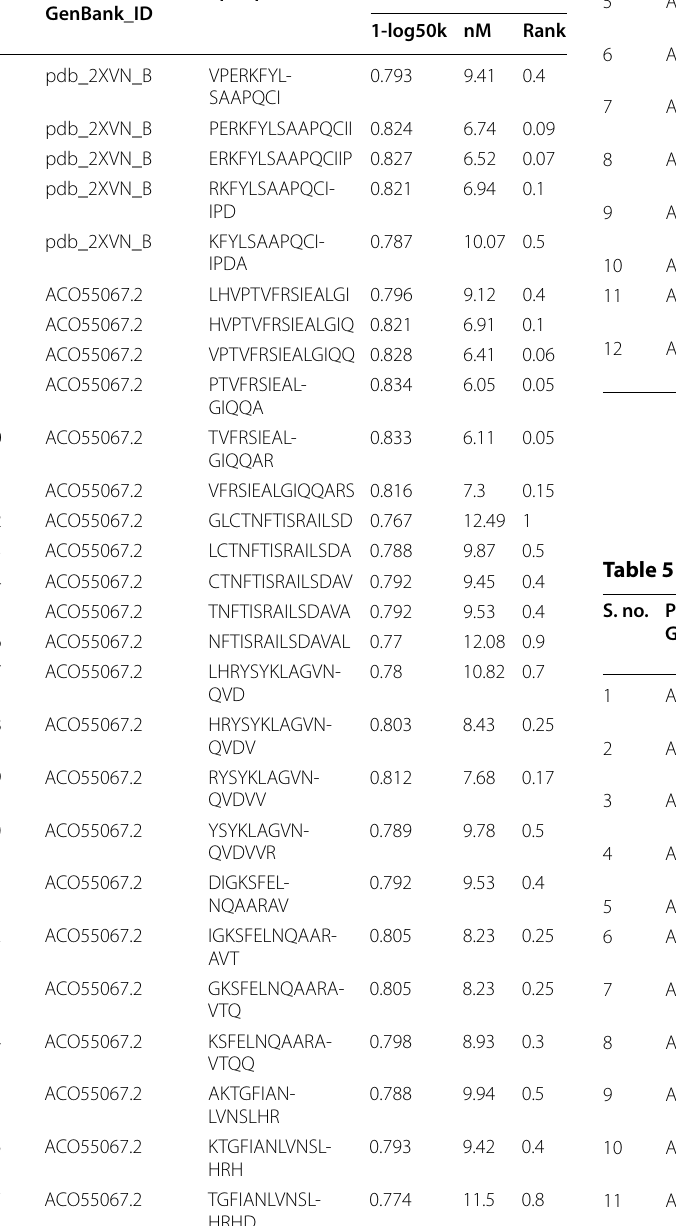
Table 3 NetMHCIIpan 3.2 scores for HLA-DRB01_0101